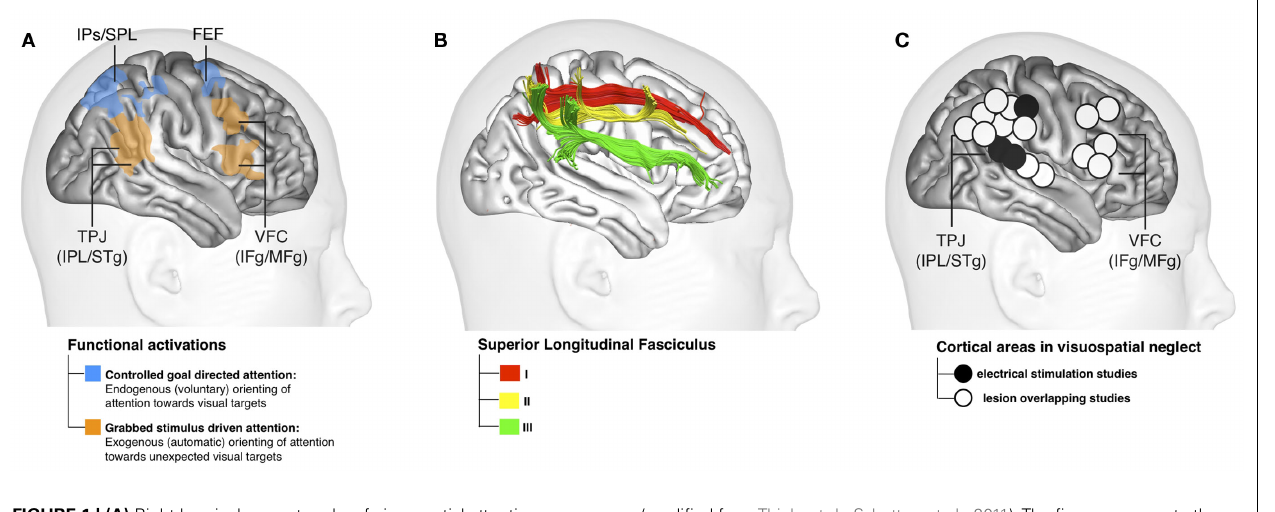
FIGURE 1 | (A) Right-hemisphere networks of visuospatial attention according to Corbetta and Shulman (2002); (B) The three branches of the Superior Longitudinal Fasciculus according toThiebaut de Schotten et al. (2011); (C) Brain regions associated to visual neglect in different studies